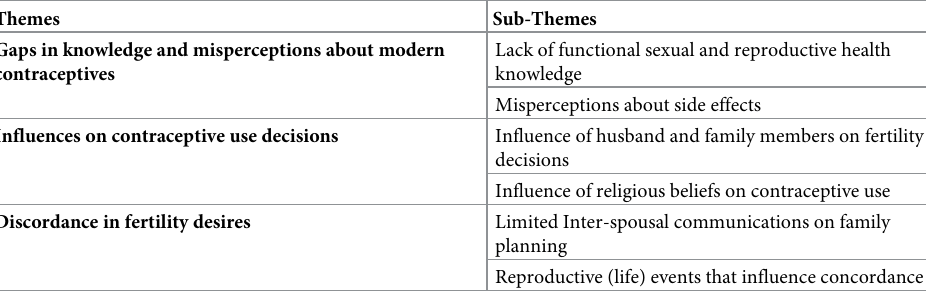
Table 2. Result themes and